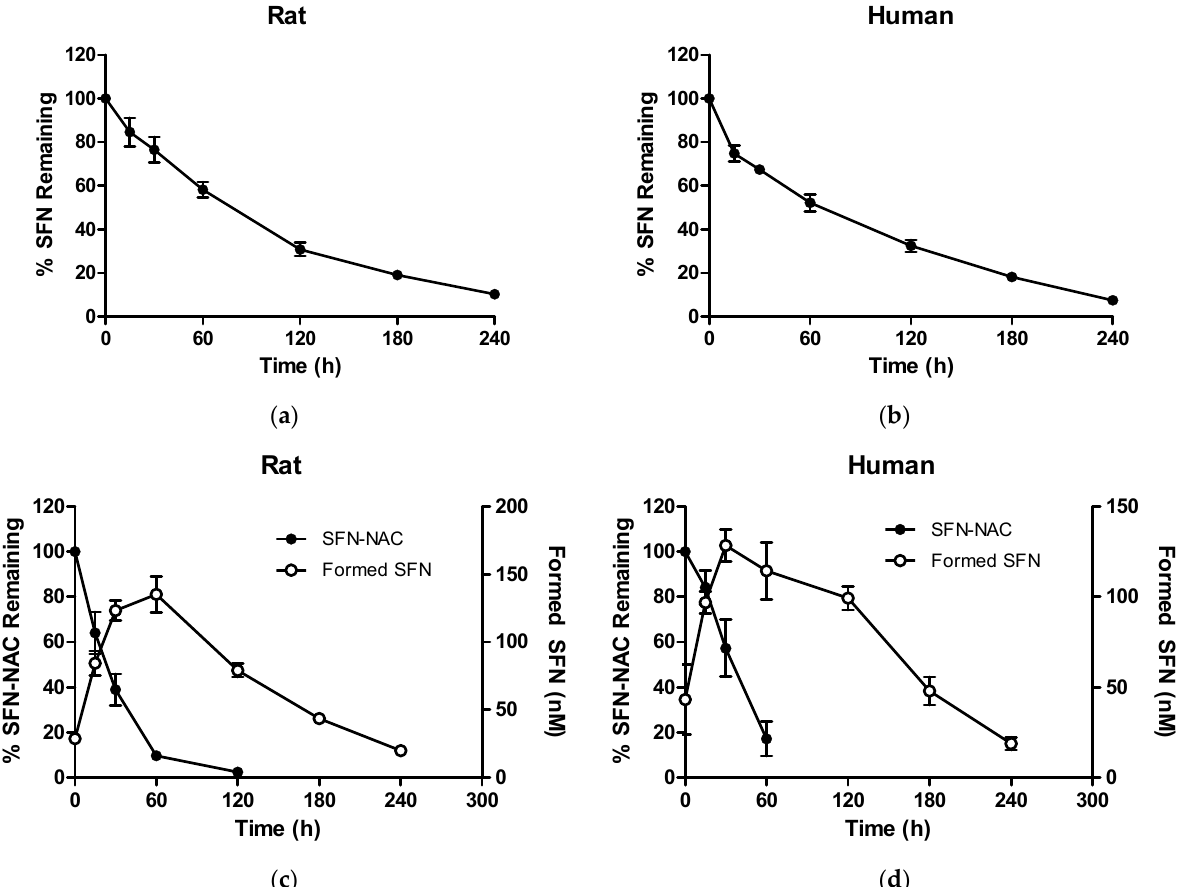
Figure 5. Percentages of remaining SFN and SFN-NAC as a function of time after incubation in plasma: ( a ) SFN in rat plasma; ( b ) SFN in human plasma; ( c ) SFN-NAC in rat plasma; ( d ) SFN-NAC in human plasma. Data values are expressed as the mean ± standard deviation ( n = 3 at each point). SFN, sulforaphane; SFN-NAC, sulforaphane N -acetylcysteine.